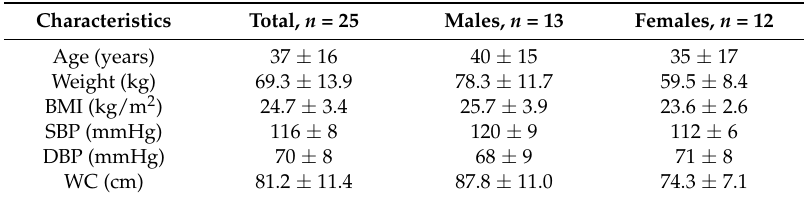
Table 1. Characteristics of study